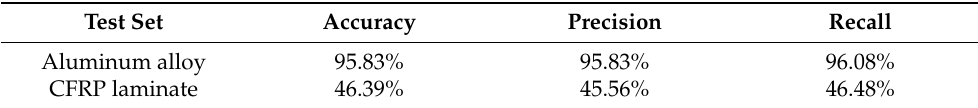
Figure 10. Identification accuracy of DL model on CFRP laminates test set. Table 1. The accuracy, precision, and recall indicators of the two test